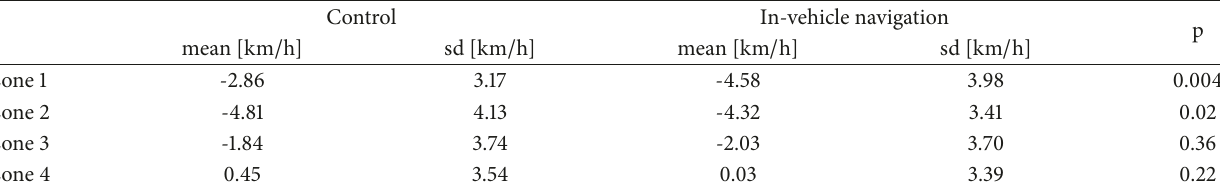
Figure 8: Distribution of speed difference under two conditions. Table 6: Statistical results of the speed difference in